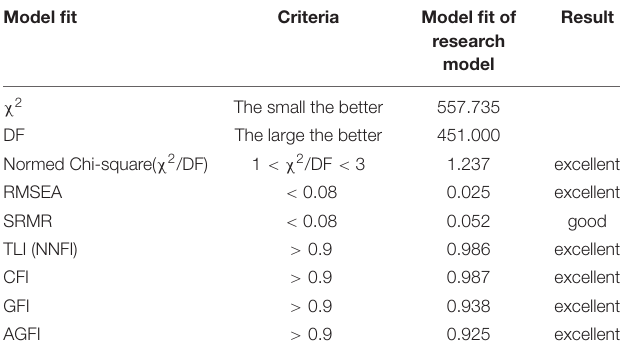
TABLE 8 | Model fit criteria and the test results.